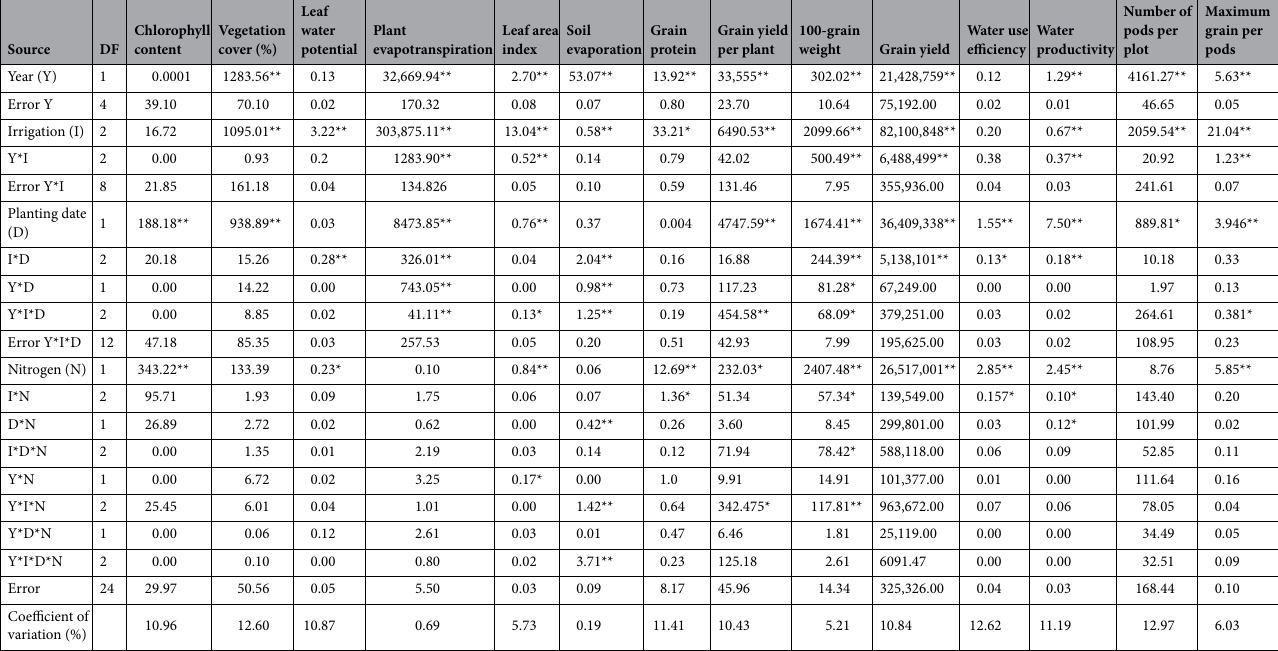
Table 2. Combined analysis of variance of irrigation regimes, sowing date, nitrogen fertilizer and year effects for pea traits.